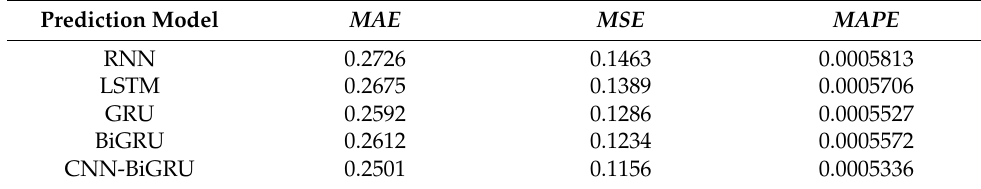
Table 6. Evaluation index of prediction results of different